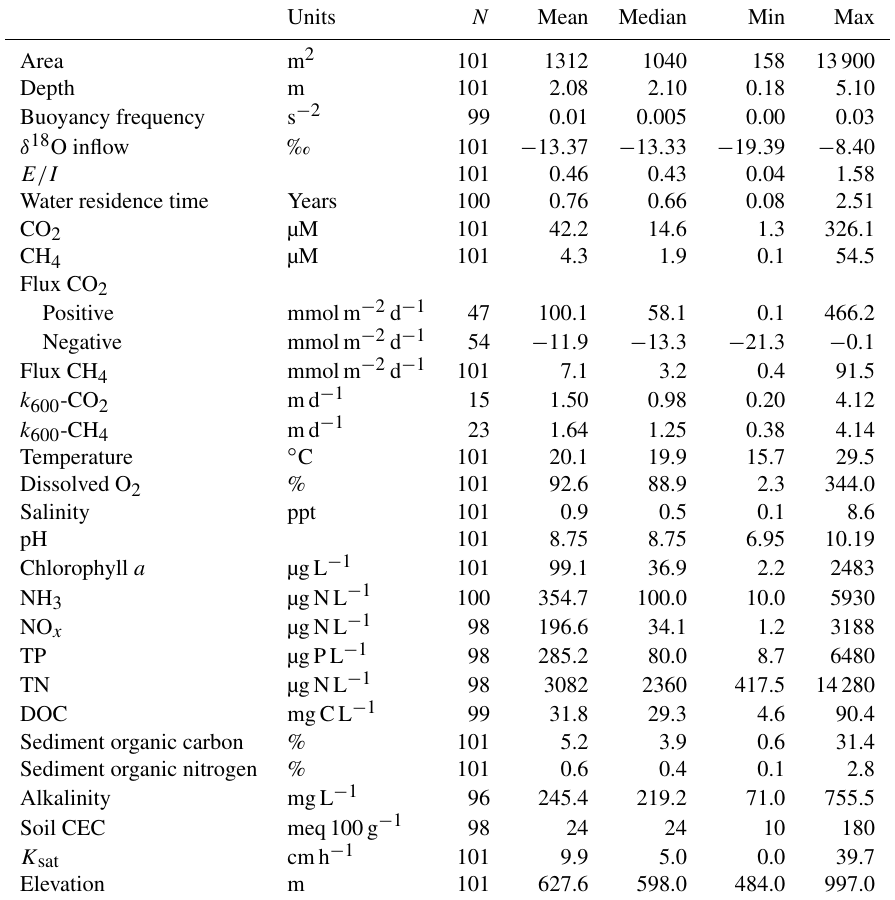
Table 1. Farm reservoir and landscape physical, hydrological, and chemical characteristics of the study sites ( n =